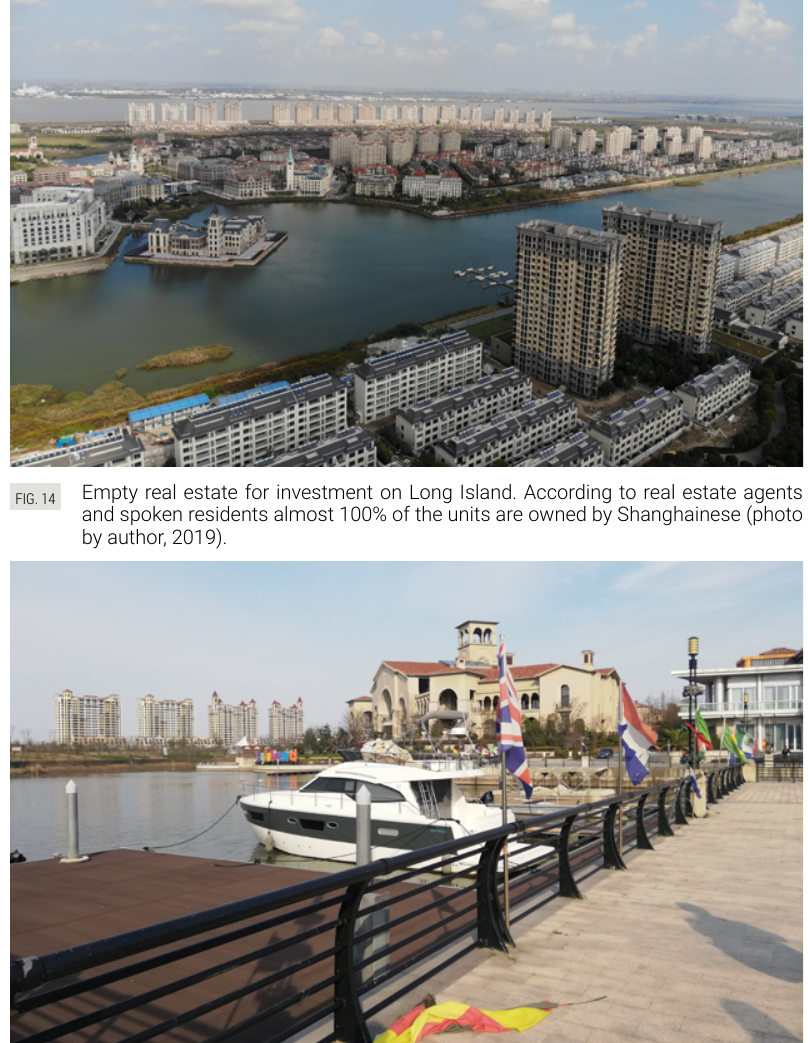
Empty real estate for investment on Long Island. According to real estate agents and spoken residents almost 100% of the units are owned by Shanghainese (photo by author,